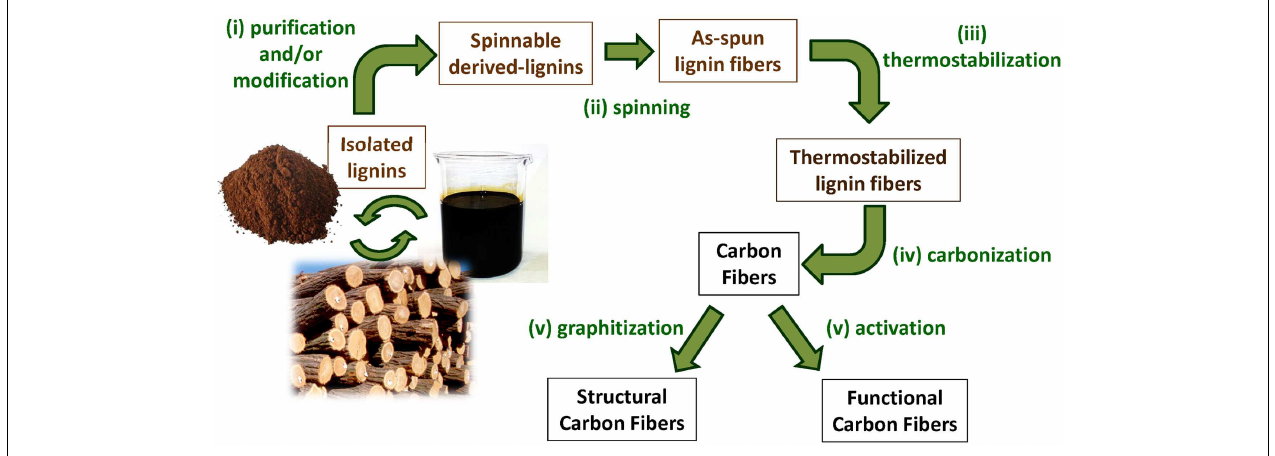
FIGURE 4 | Simplified scheme of lignin-based CF manufacture